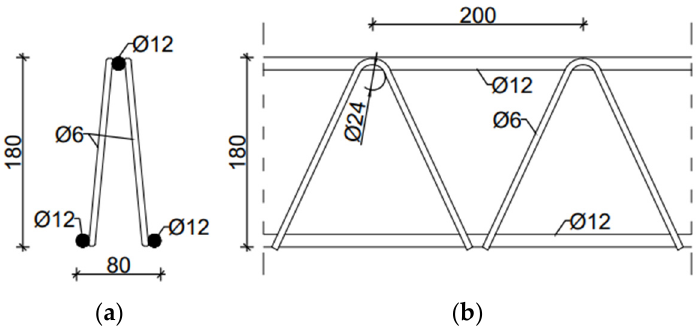
Figure 1. D-type spatial truss ( a ) X-X view; ( b ) Y-Y view.